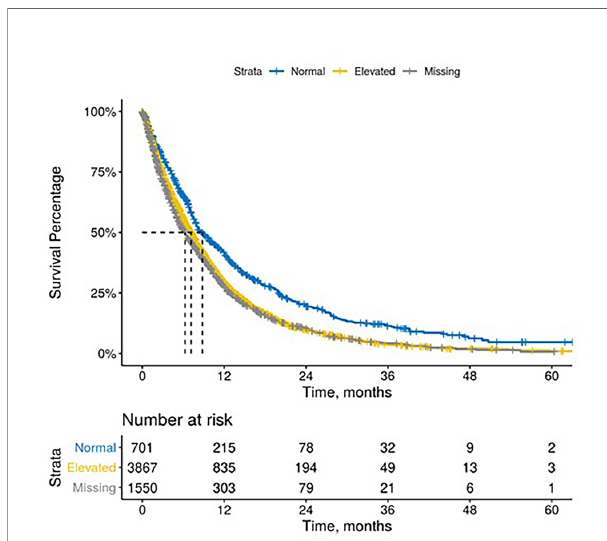
FIGURE 1 | Overall survival by Baseline Carbohydrate Antigen 19-9.